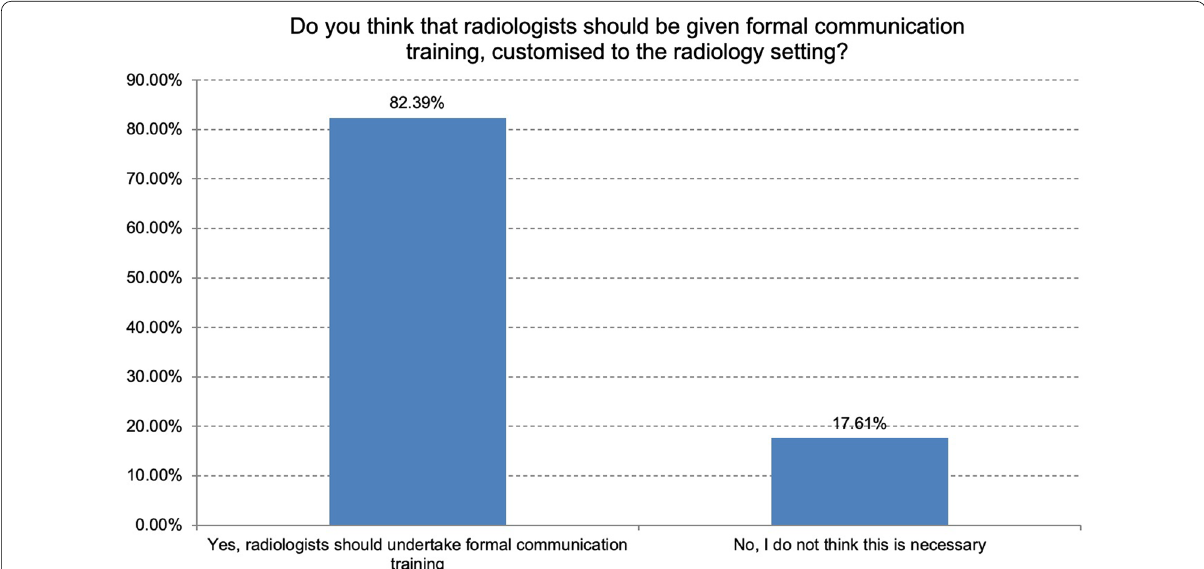
Fig. 10 Do you think that radiologists should be given formal communication training, customised to the radiology setting? (considering that the radiologist may have limited time in the e.g. ultrasound list, they cannot go into detail with patients but perhaps should have training in “catching” the patients first shock, preparing patient for the next steps but also finding a way that makes it easier for radiologists to know how to deal with delivering bad news?) (responses n =